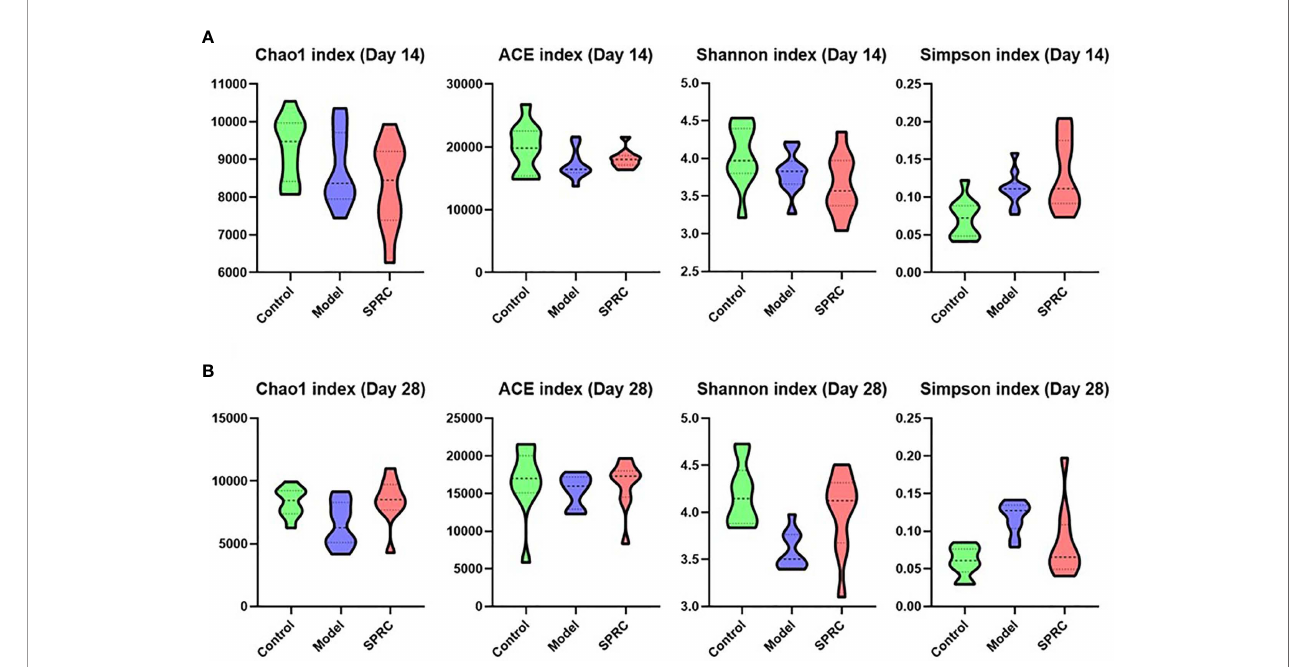
FIGURE 3 | Comparison of the biodiversity between groups. The violin plot outlines illustrate the diversity of gut microbiota on the 14 th and 28 th days, and the width of the shaded area represents the proportion of the data in each region. (A) On the 14 th day, compared with other groups, higher stool microbial richness was observed in the Control group, as estimated by Chao1 and ACE indices. Accordingly, microbial diversity in the Control group, as estimated by Shannon and Simpson indices, was also increased. (B) On the 28 th day, a relatively higher level of microbial richness was observed in the Control and SPRC groups than in the Model group. Accordingly, microbial diversity in the Control and SPRC groups showed a similar trend of higher levels than that in the Model group (n=10).